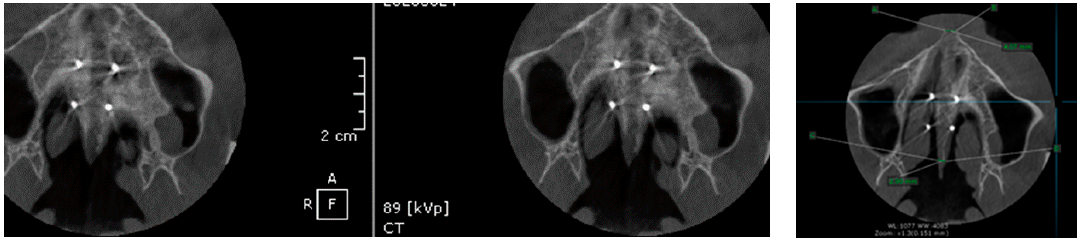
Figure 8. The split of the palatal suture.